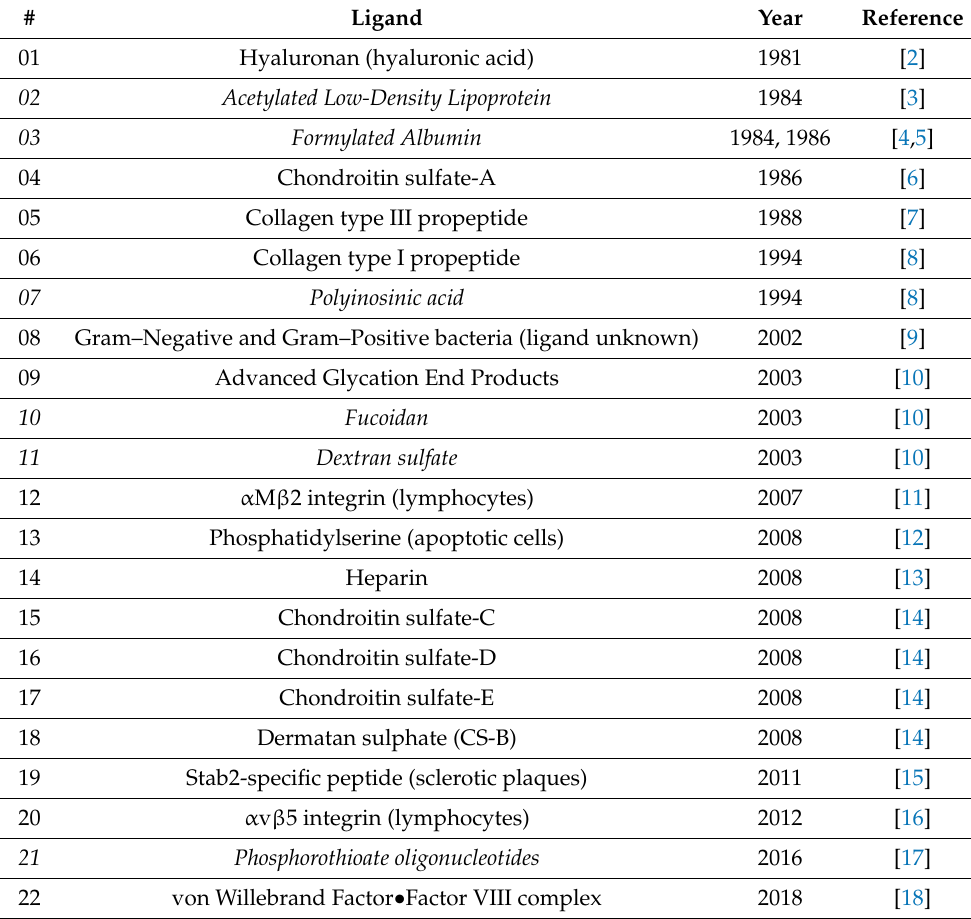
Table 1. Discovery of Ligands for the hyaluronan receptor for endocytosis (HARE) and Stabilin-2.